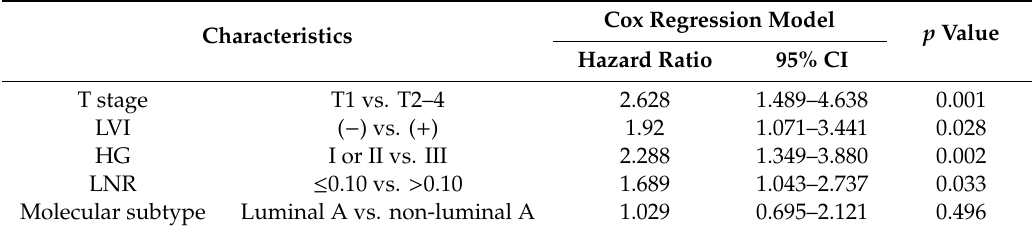
Table 4. Multivariate analysis of disease-free survival.